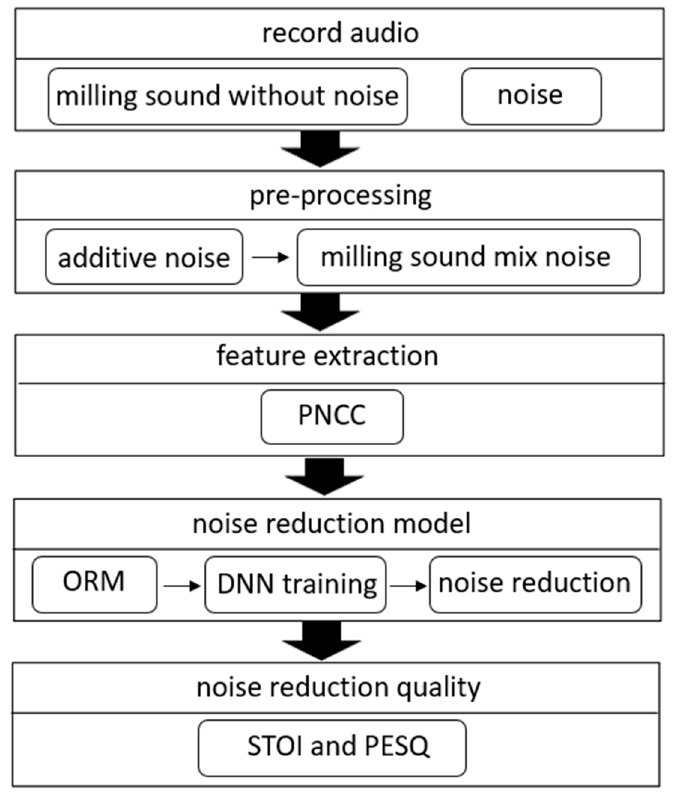
Figure 7. Flow chart of noise reduction model.